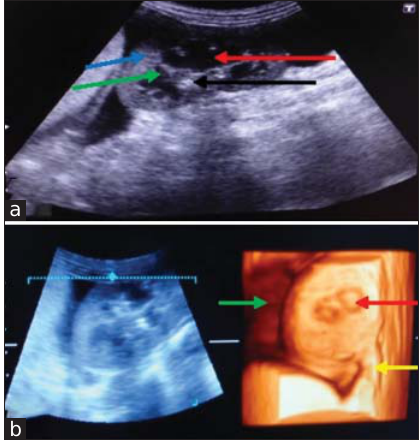
Figure-5: Hydronephrosis Case 3: (a) In two-dimensional ultrasonogram of kidney with dilated renal pelvis (red arrow). Atrophied renal parenchyma with loss of architectural details (black arrow), (b) in three-dimensional ultrasonogram fluid filled areas (red arrow), course of ureter (yellow arrow) and ascetic fluid outsite the kidney (green